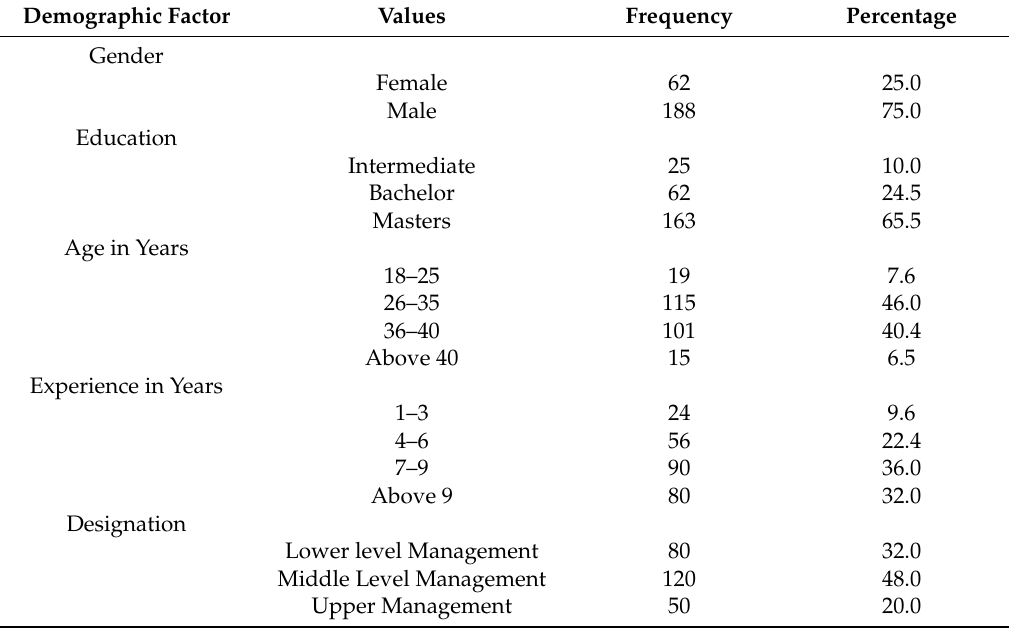
Table 1. Profile of